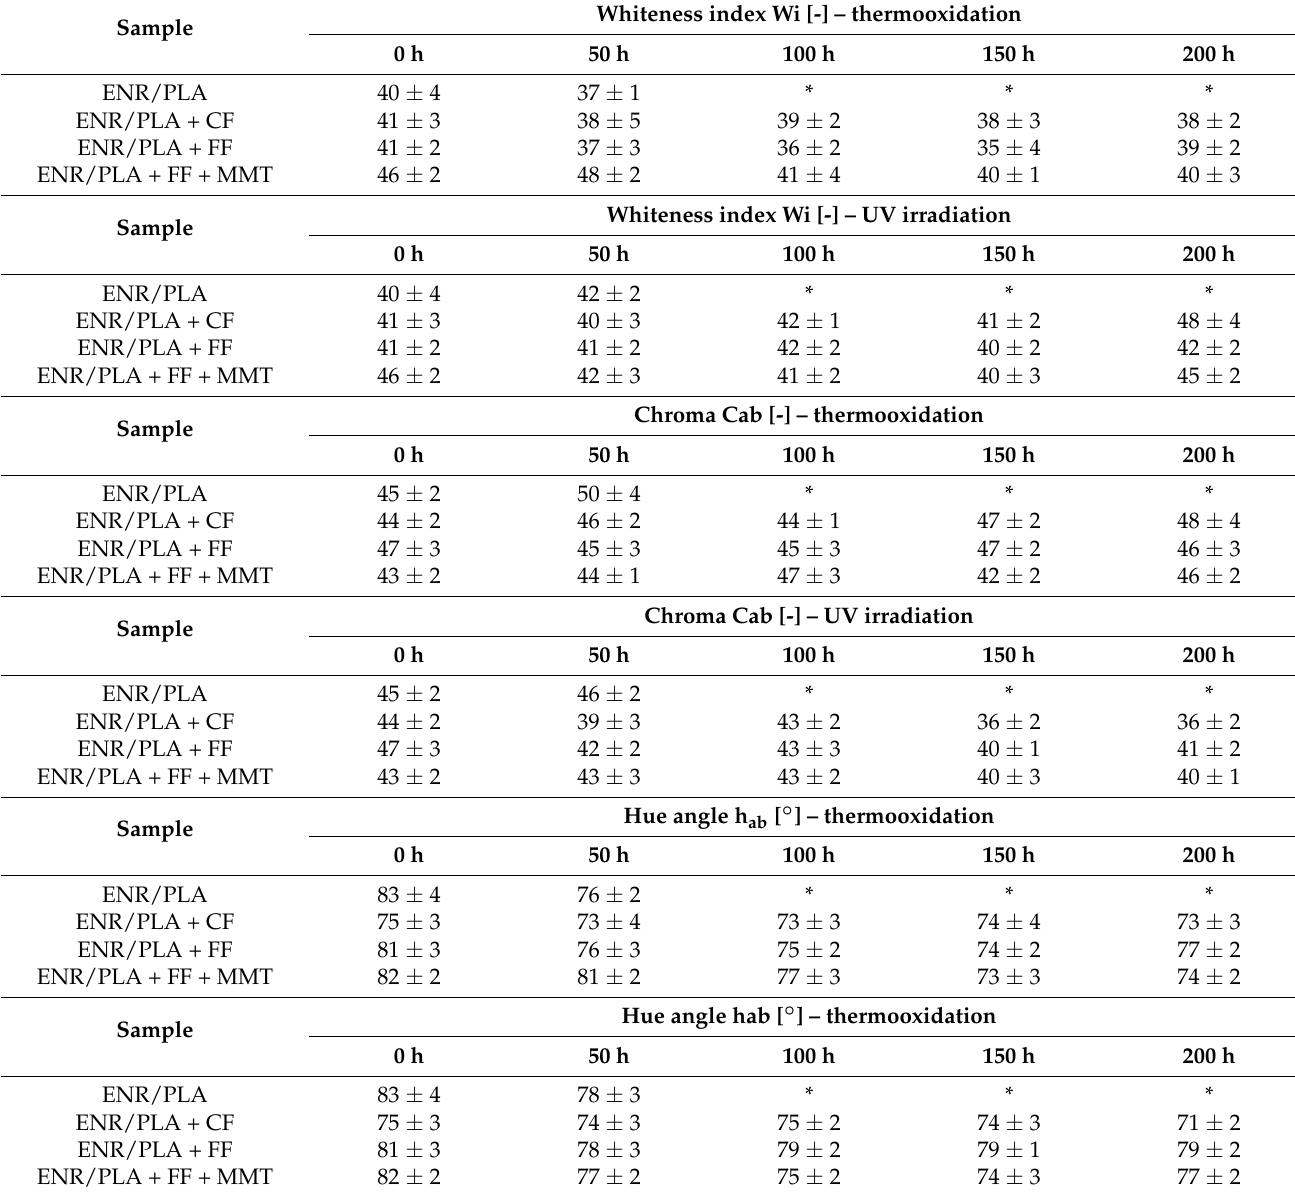
Table 3. Additional parameters contributing to the color change in ENR/PLA blends and their variations during the thermo-oxidative and UV accelerated aging processes: whiteness index, chroma, hue angle. * sample too brittle to be examined with the selected method; the measurement was